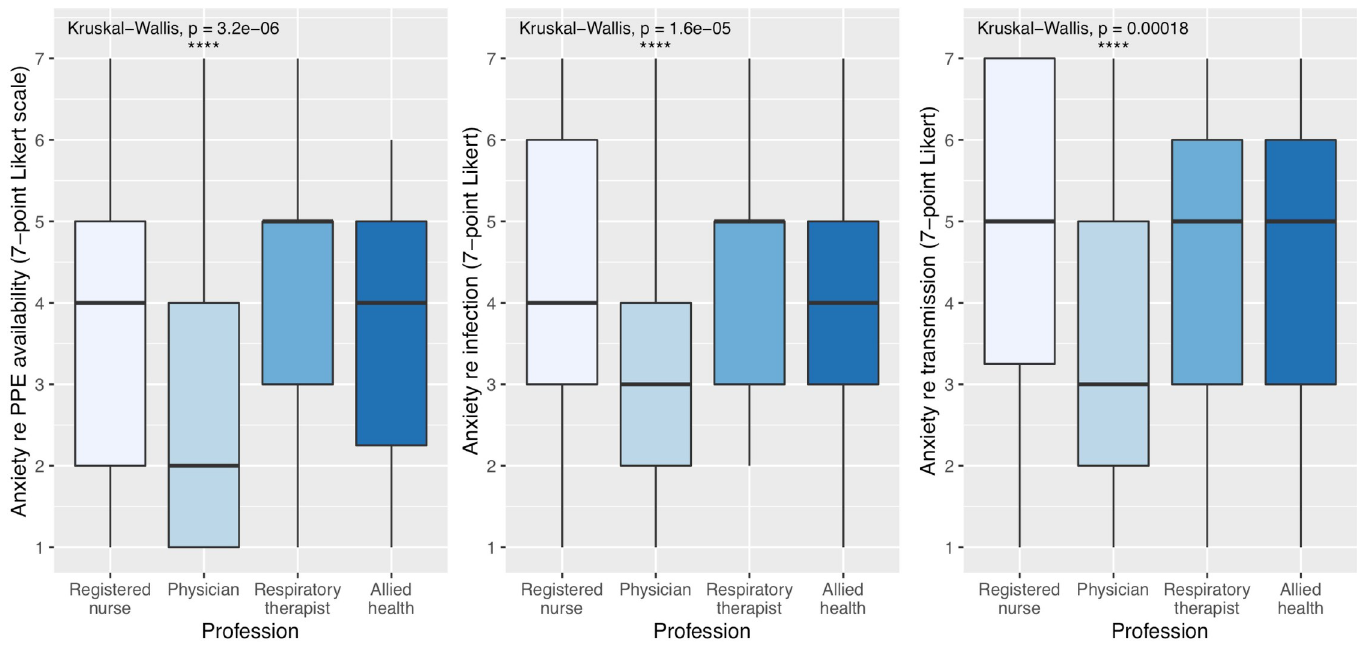
Fig 6. Boxplot of anxiety levels subdivided by profession. (A) Anxiety with respect to PPE availability. (B) Anxiety with respect to risk of becoming infected with COVID-19. (C) Anxiety with respect to risk of transmitting COVID-19 to family or loved ones.